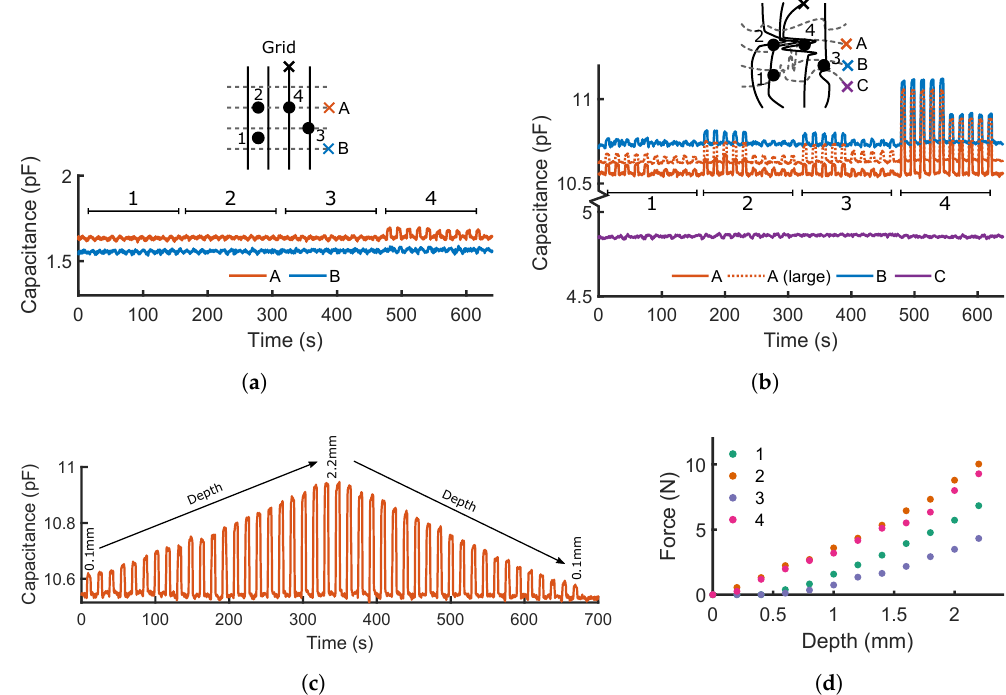
Figure 7. Capacitive responses of the two morphologies when probed and measured at different locations. ( a ) The grid morphology only yields a clear response when the intersection of the measured lines is directly probed at location 4. ( b ) The optimized morphology clearly responds at all 4 locations, discerning between probed depths of 1 mm and 2 mm. ( c ) Location 4 of the optimized morphology is probed at 22 different depths. ( d ) The compressive forces corresponding to each of the 22 depths at the 4 locations marked in Figure